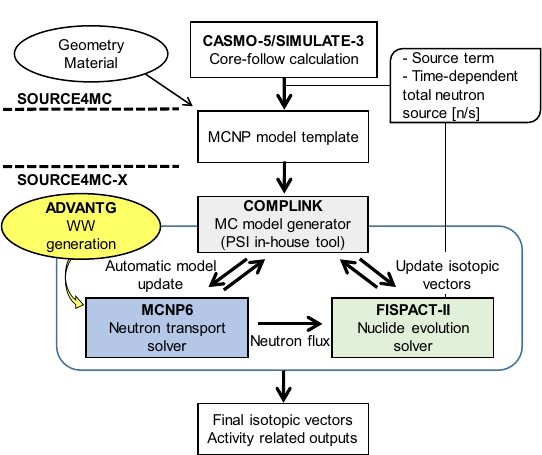
Figure 1. PSI methodology for LWR structures irradiation & activation evaluations.